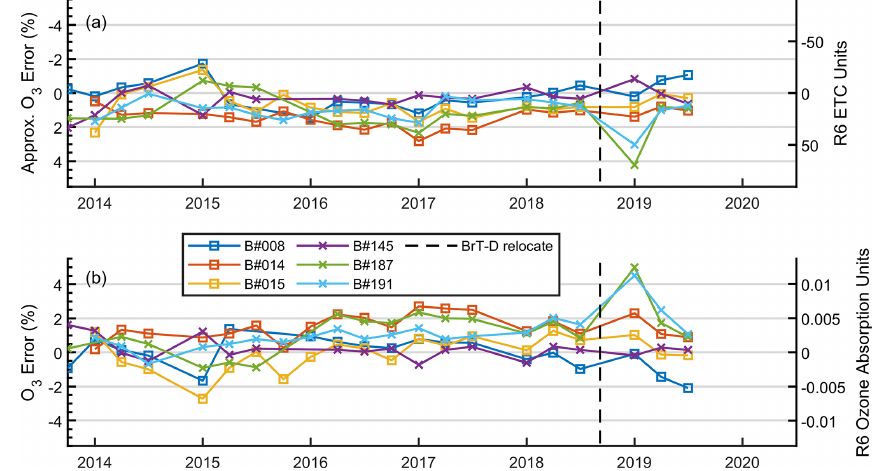
Figure 5. Relative systematic uncertainties in ETCs and effective ozone absorption coefficients estimated using Model 3. Description of y axes is in Fig. 3. Each point on the graph represents a 3-month average. The black dash line represents the time when BrT-D was relocated to